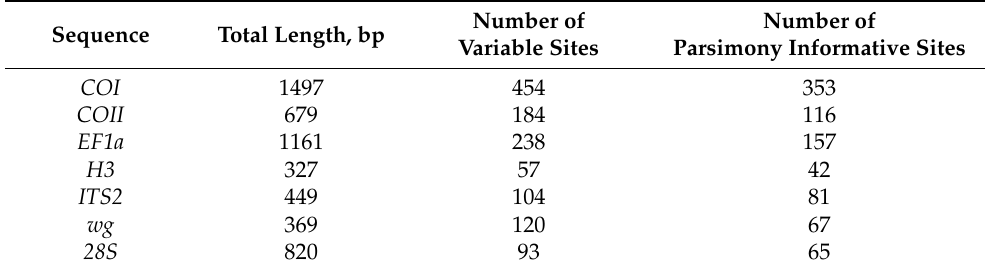
Table 2. Fragments of DNA sequences used for phylogenetic analysis. Sequence Total Length, bp